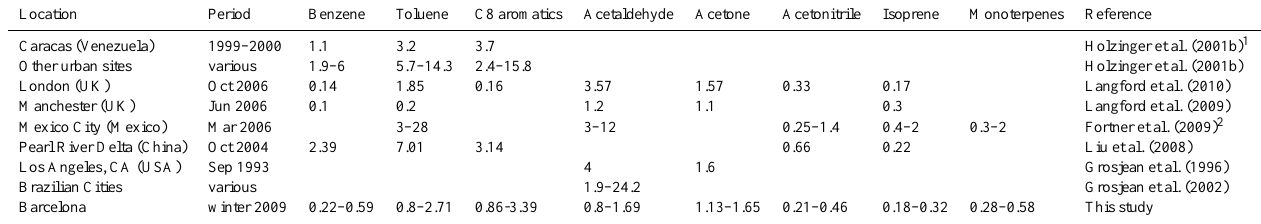
Table 5. VOC mixing ratios (ppbv) in the urban areas reported in the literature compared to those reported in this study for Barcelona. Values shown are averages or ranges of average